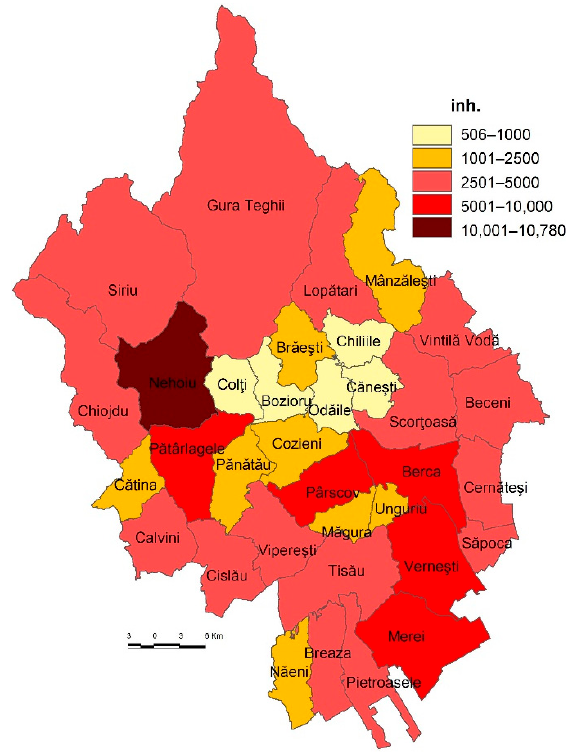
Figure 2. Demographic size at LAU level, 2021.